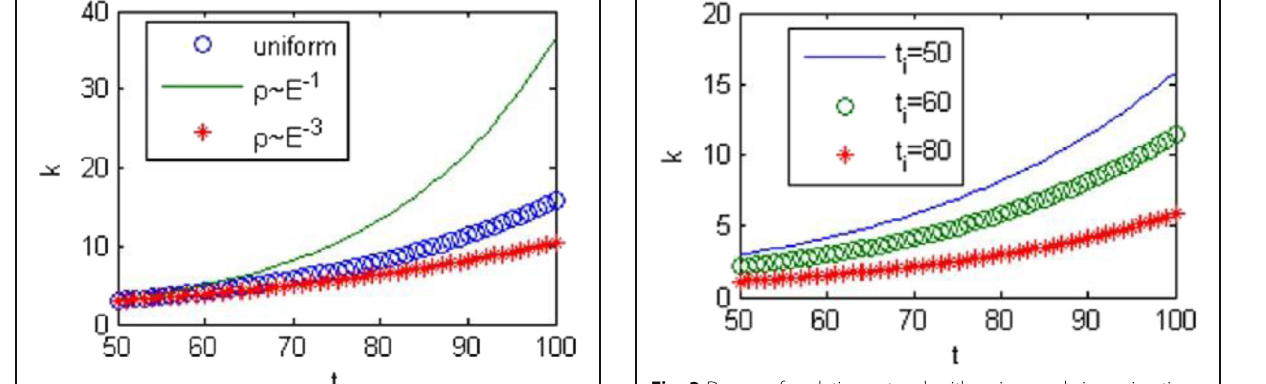
Fig. 3 Degree of evolution network with various node incoming time